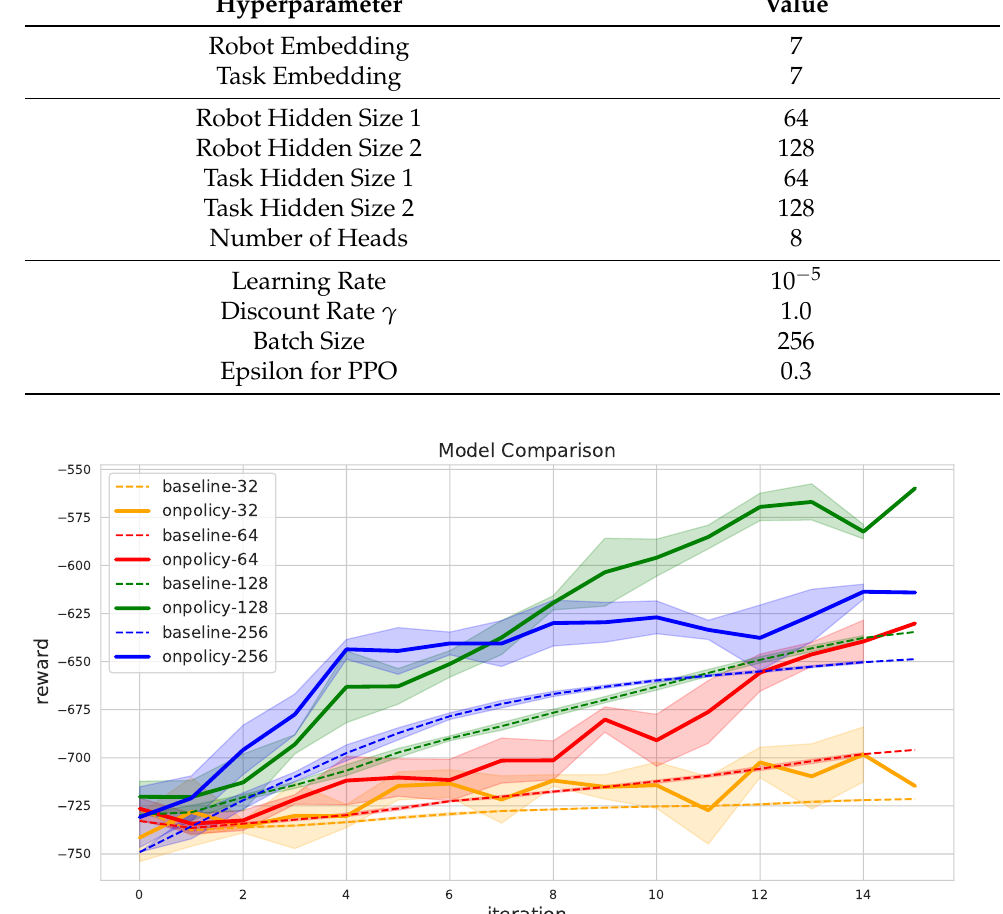
Figure A2. Effect of the size of the hidden dimension for 20 samples in 5 robots and 50 tasks